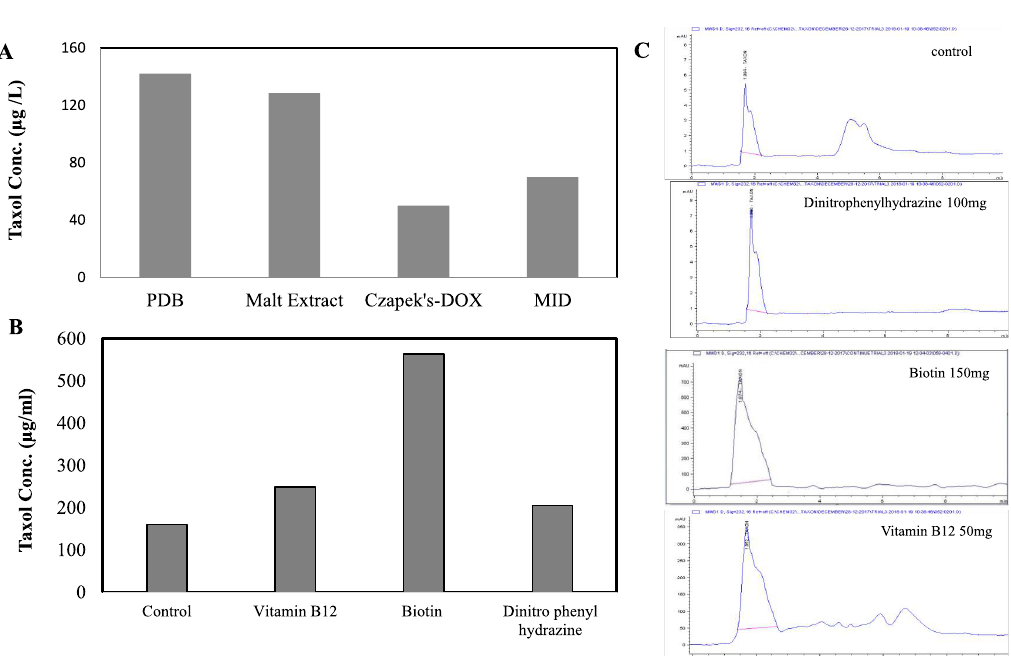
Fig. 3. Taxol yield of A. terreus by growing on different types of media and in response to different growth inhibitors. A, The fungal isolate was grown on different potato dextrose broth, malt extract, Czapek's-Dox and MID media (El- Sayed et al, 2018), and the Taxol was extracted and determined by HPLC. The cultures of A. terreus were amended with different inhibitors, incubated at standard conditions, then Taxol was extracted and quantified (B) from HPLC chromatogram (C).